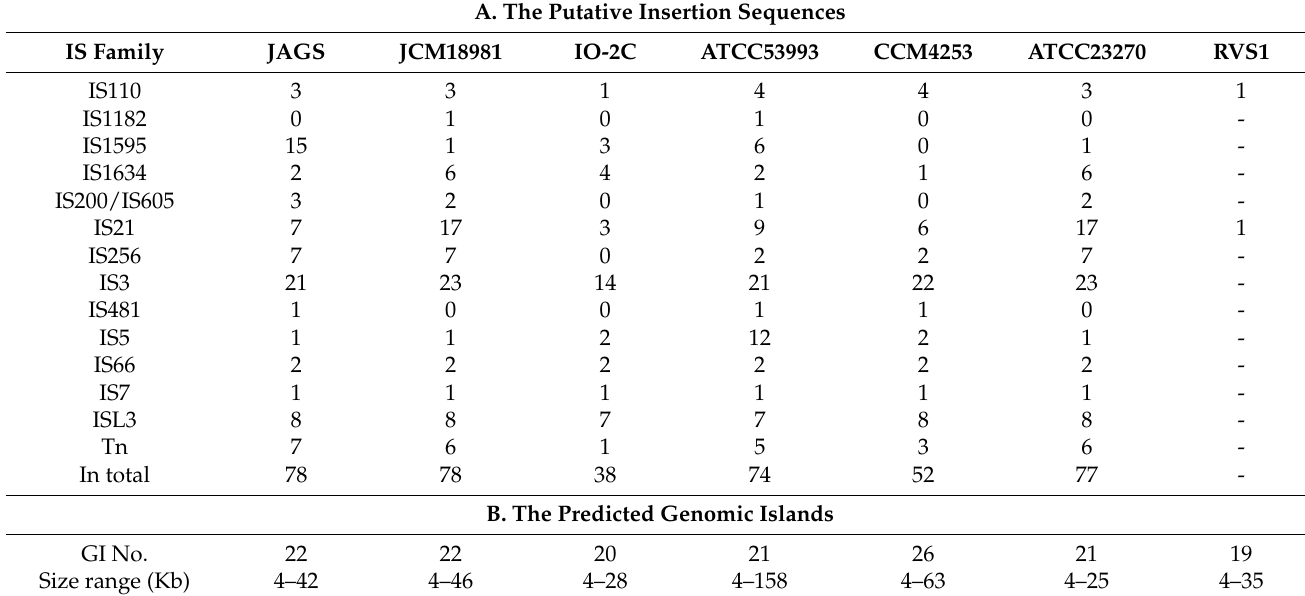
Table 2. The prediction of mobile genetic elements including insertion sequences (ISs) and genomic islands (GIs) of the Acidithiobacillus strains studied.